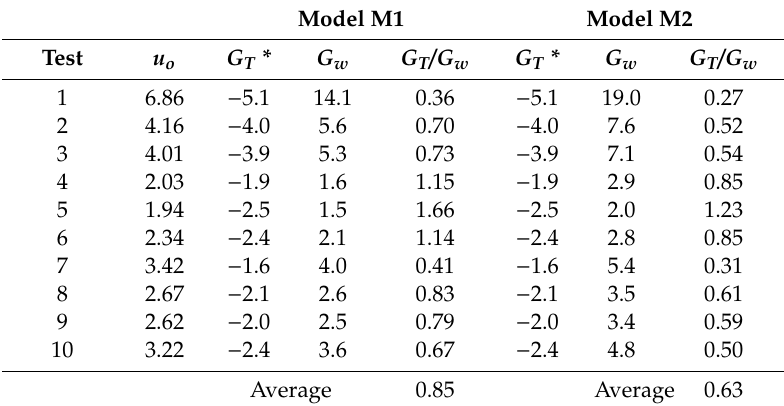
Table 9. Ventilation flow rates generated by the wind e ff ect ( G w ) and the thermal e ff ect ( G T ) estimated by applying ventilation models M1 and M2 using the fits C wM2 ( δ ), C dVS ( u o ), and C dWR ( u o ). Model M1 Model M2 Test u o G T * G w G T / G